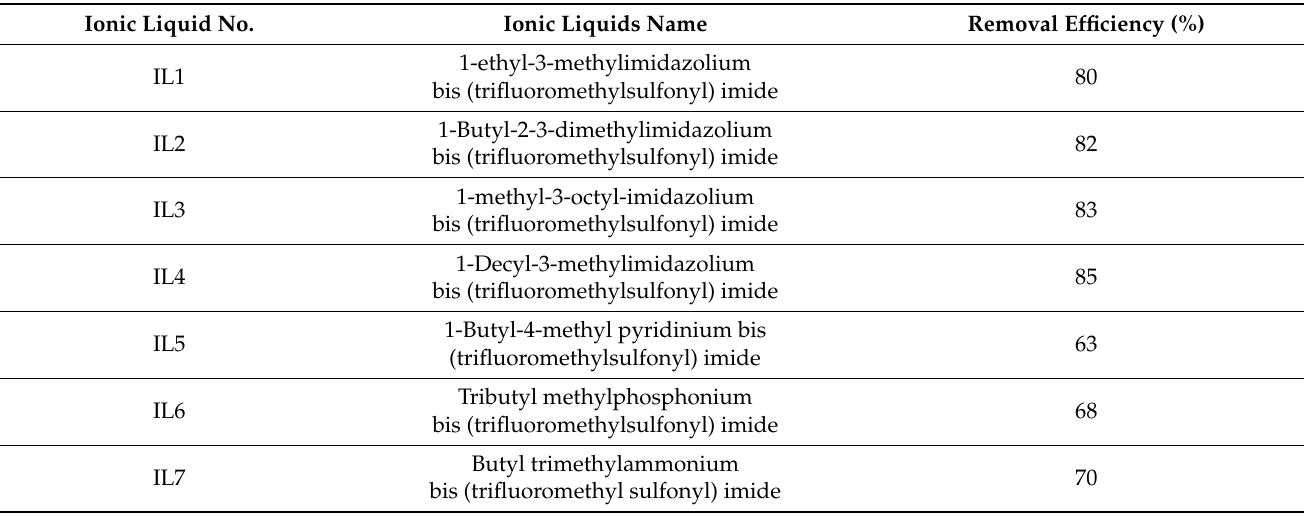
Screening of the seven ILs for the extraction of oil from PW at the initial concentration = 500 mg/L, contact time = 5 min, phase ratio (IL:PW) = 1:5, and temperature = 25 ◦ C. Ionic Liquid